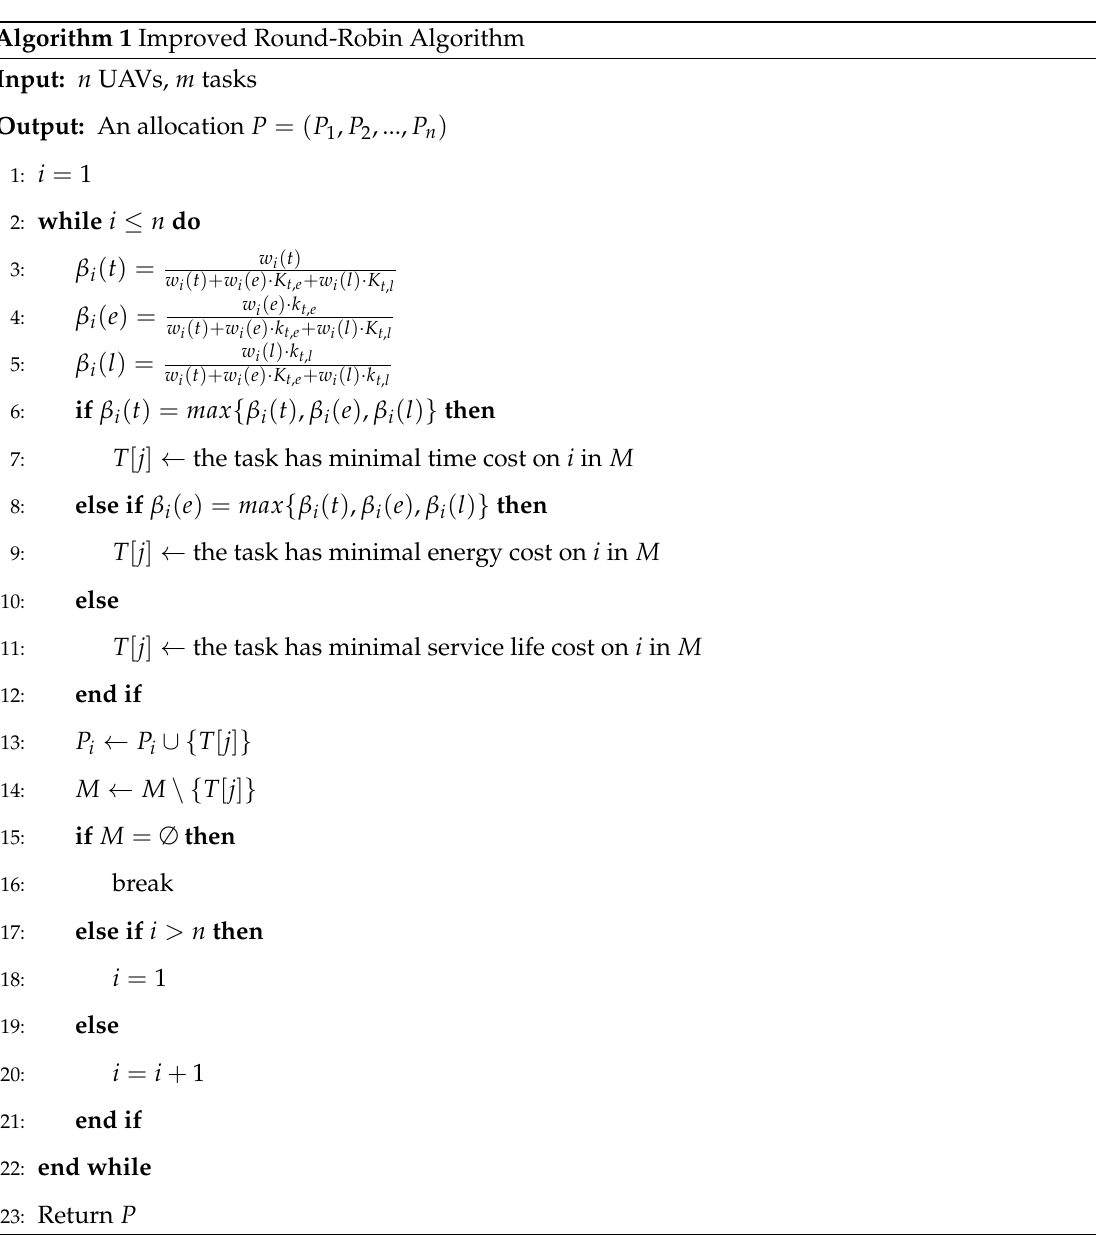
Algorithm 1 Improved Round-Robin